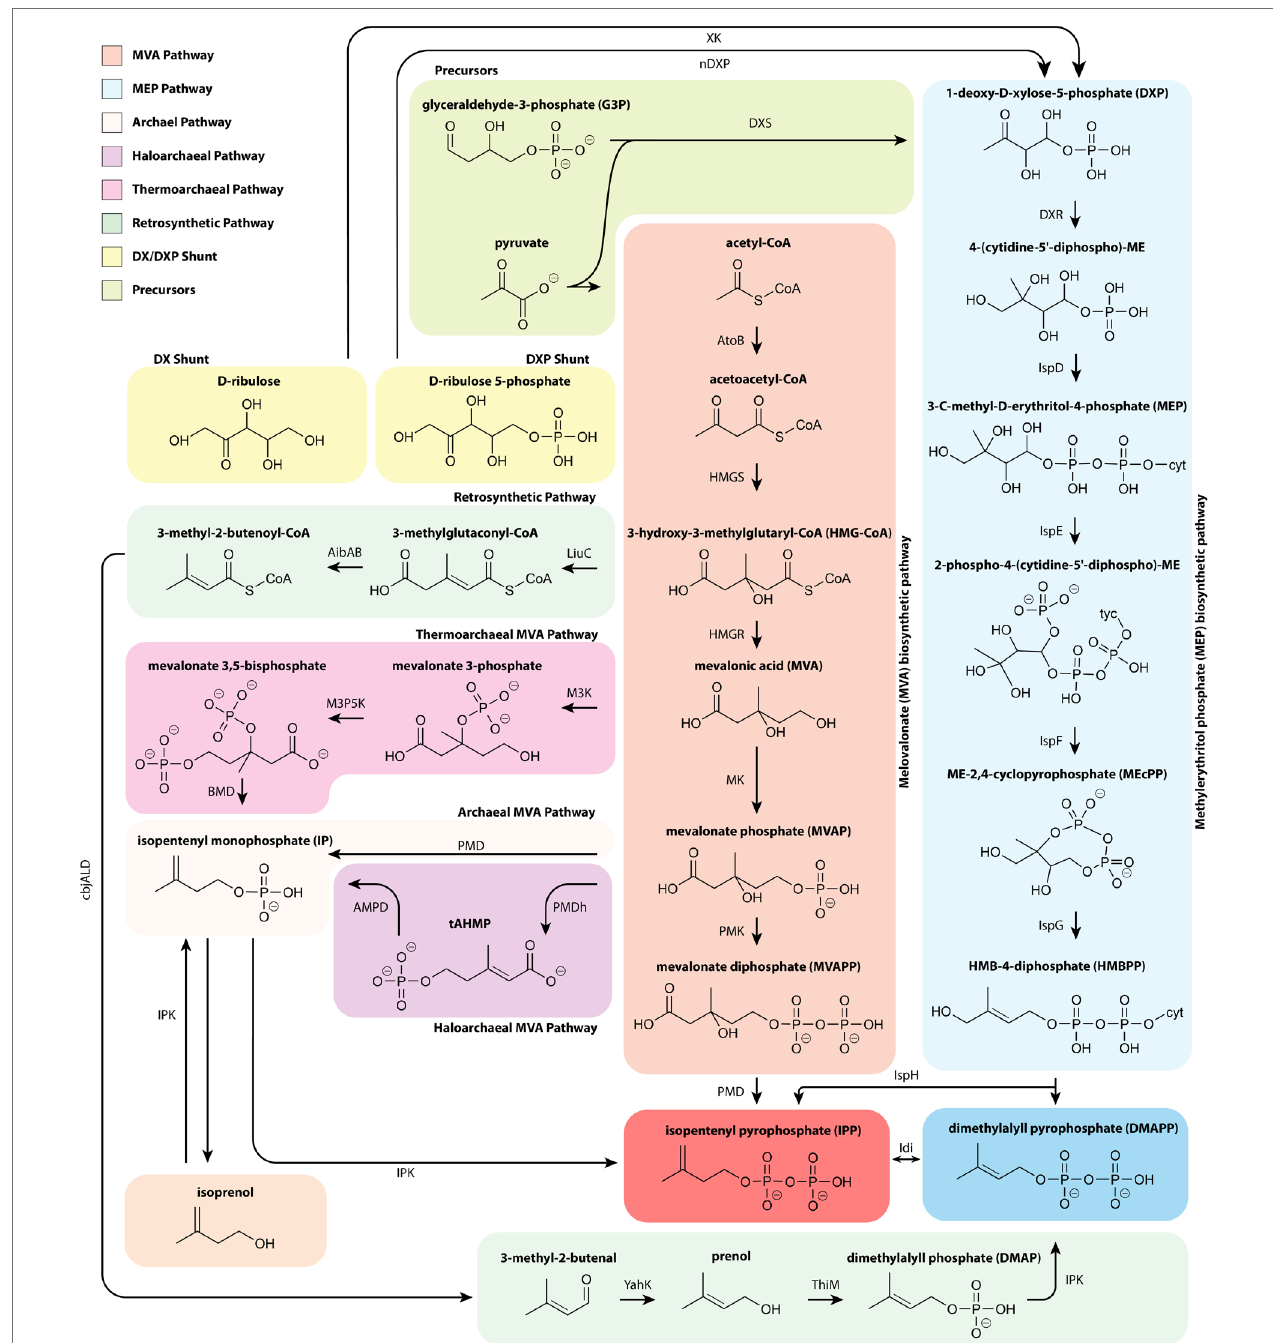
FIGURE 1 | A depiction of isoprenoid synthesis through the core 6 enzyme MVA and 7 enzyme MEP pathways. Also depicted are the newly discovered archaeal branches from the MVA pathway. The thermoarchaeal-type branch begins with mevalonic acid whereas the archaeal and haloarchaeal-type branches stem from MVAP. Typically, isoprenoids are synthesized by acetyl-CoA, pyruvate, and G3P, however IPP and DMAPP can also be synthesized from C5 alcohols, D-ribulose or D-ribulose-5-phosphate, and a synthetic route in which HMG-CoA is ultimately converted to prenol. AibAB, 3-methylglutaconyl-coenzyme decarboxylase; AtoB, acetyl-CoA acetyltransferase; BMD, bisphosphomevalonate decarboxylase; cbjALD, 3-methylcrotonyl-CoA reductase; DXR, 1-deoxy-D-xylulose 5-phosphate reductase; DXS, 1-deoxy-D-xylulose 5-phosphate synthase; HMGR, 3-hydroxy-3-methylglutaryl-CoA reductase; HMGS, 3-hydroxy-3-methylglutaryl-CoA synthase; IDI, isopentenyl diphosphate isomerase; IPK, isopentenyl phosphate kinase; IspD, 2-C-methyl-D-erythritol 4-phosphate cytidylyltransferase; IspE, 4-diphosphocytidyl-2-C-methyl-D-erythritol kinase; IspF, 2-C-methyl-D-erythritol 2,4-cyclodiphosphate synthase; IspG, 4-hydroxy-3-methylbut-2-enyl diphosphate synthase; IspH, 4-hydroxy-3-methylbut-2-enyl diphosphate reductase; LiuC, 3-hydroxy-3-methylglutaryl CoA dehydratase; M3K, Mevalonate 3-kinase; M3P5K, Mevalonate 2-phosphate-kinase; nDXP, 1-deoxyxylulose-5-phosphate synthase; PMD, phosphomevalonate decarboxylase; PMK, phosphomevalonate kinase; tAHMP, anhydromevalonate diphosphate decarboxylase; ThiM, hydroxyethylthiazole kinase; XK, xylulose kinase; YahK, aldehyde